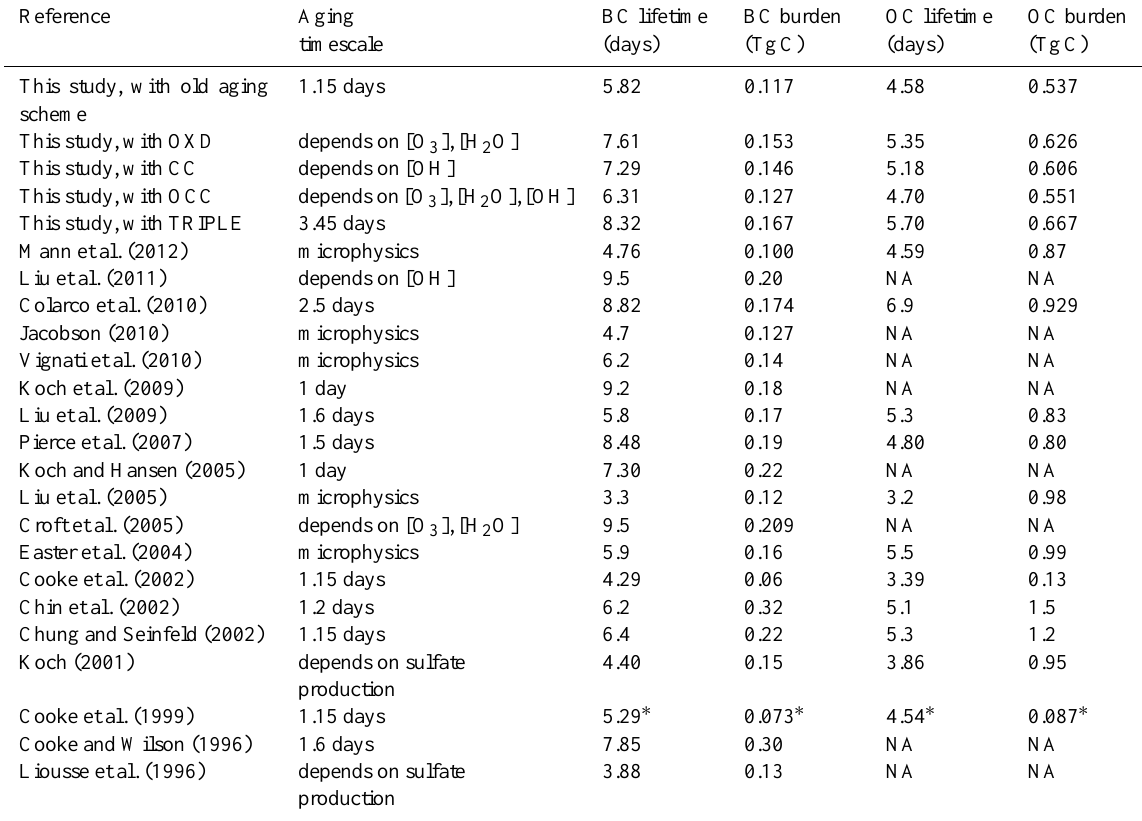
Table 1. Model simulated global budgets of carbonaceous